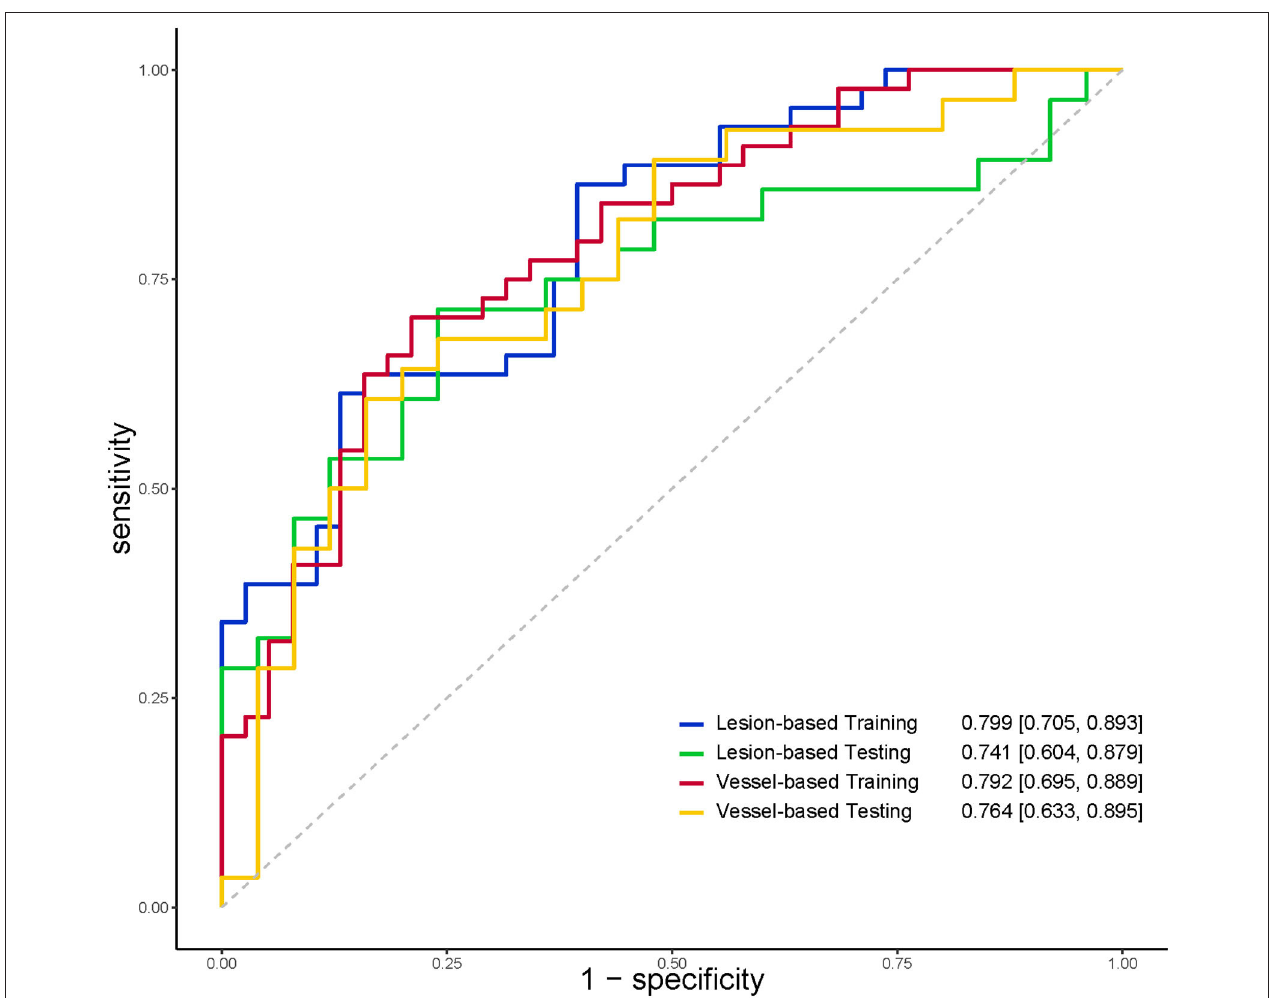
FIGURE 6 | ROC curves indicated comparable diagnostic performance between vessel-based and lesion-based PCAT radiomics models for identifying functionally significant coronary stenosis. PCAT, pericoronary adipose tissue; ROC, receiver operating